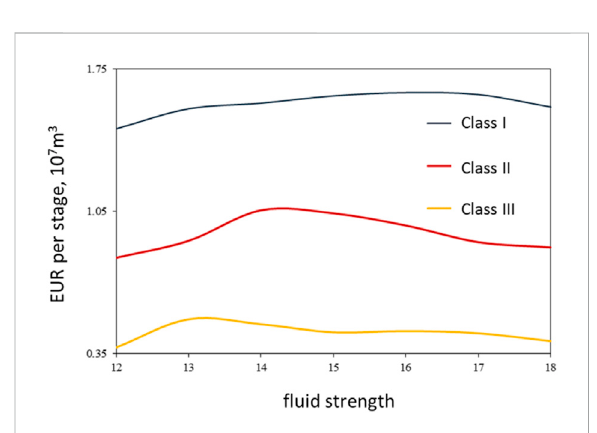
FIGURE 12 Simulated SRV in various reservoirs of JQ511 platform at 14 m 3 /min